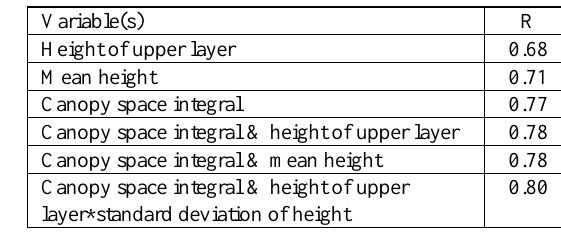
Table 3. Results of correlation with timber